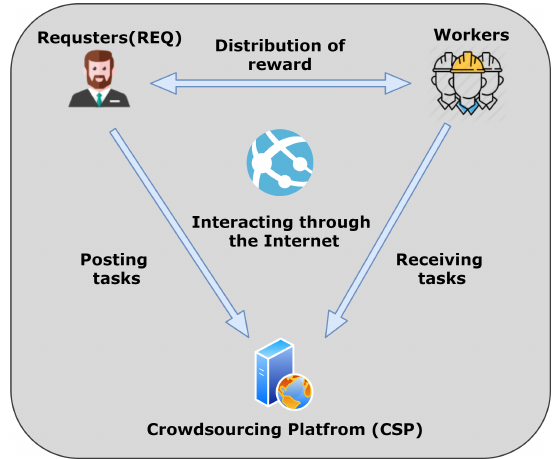
Figure 1. A traditional centralized crowdsourcing